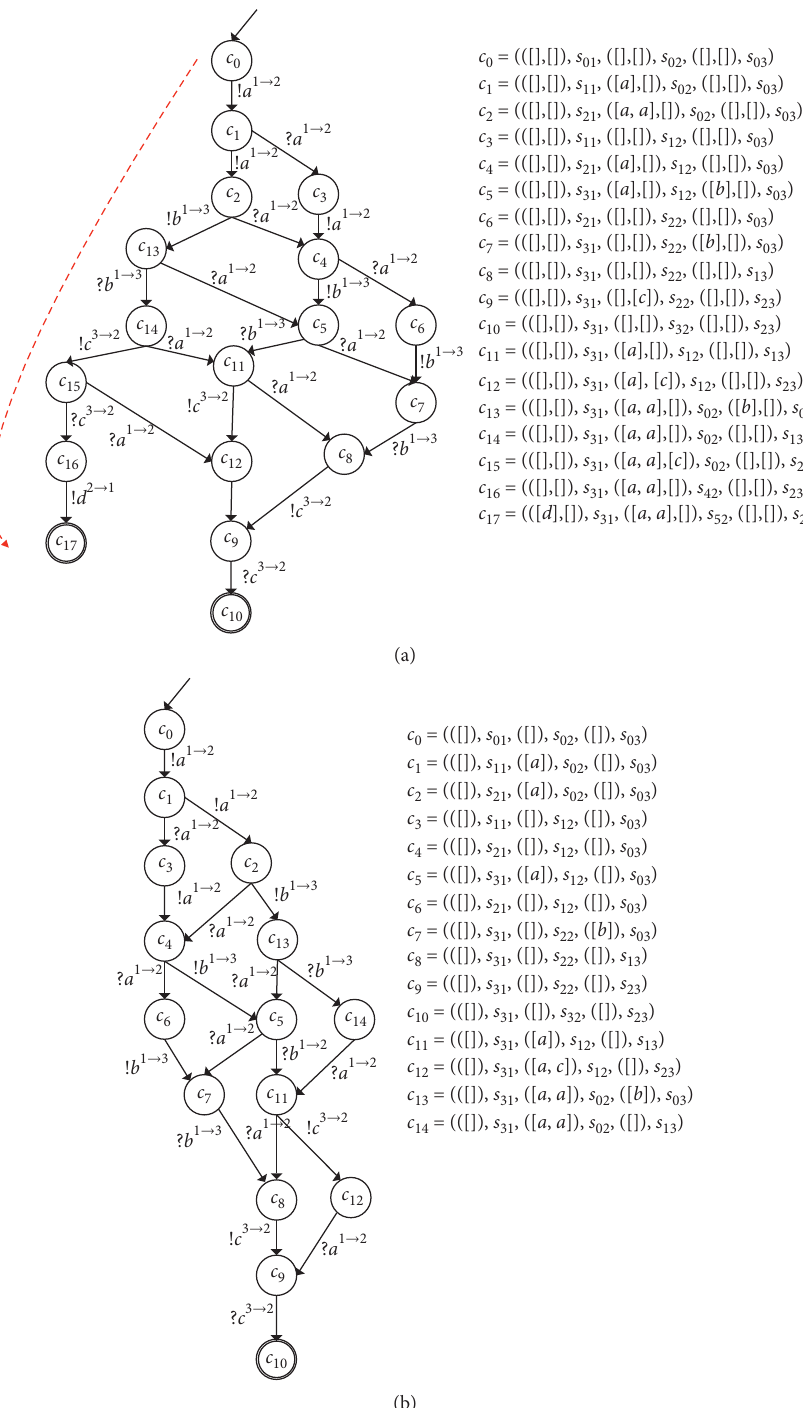
Figure 3: The asynchronous interaction behavior of the microservice system with buffers of size 2 shown in Figure 1. (a) The peer-to-peer communication. (b) The mailbox communication.